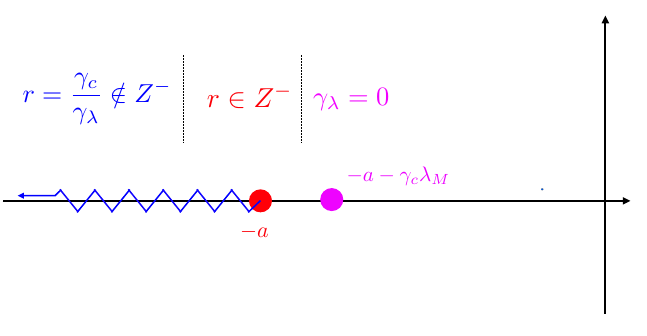
Figure 1 . Analytical structures of the celestial amplitudes considering one-loop resummation. The shifted pole position depends on the sign of γ